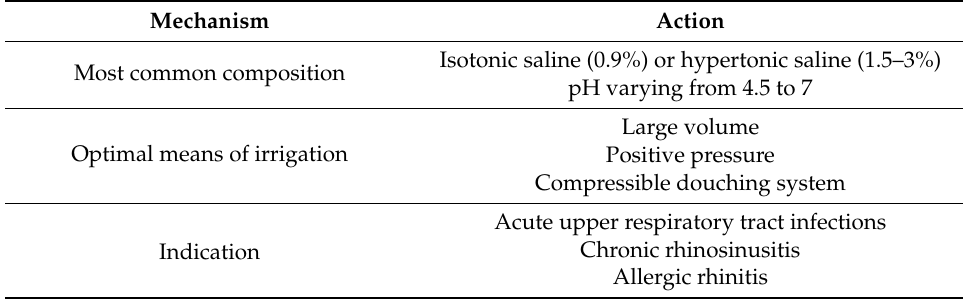
Table 2. Main solutions, means of irrigation, and indication of nasal irrigation